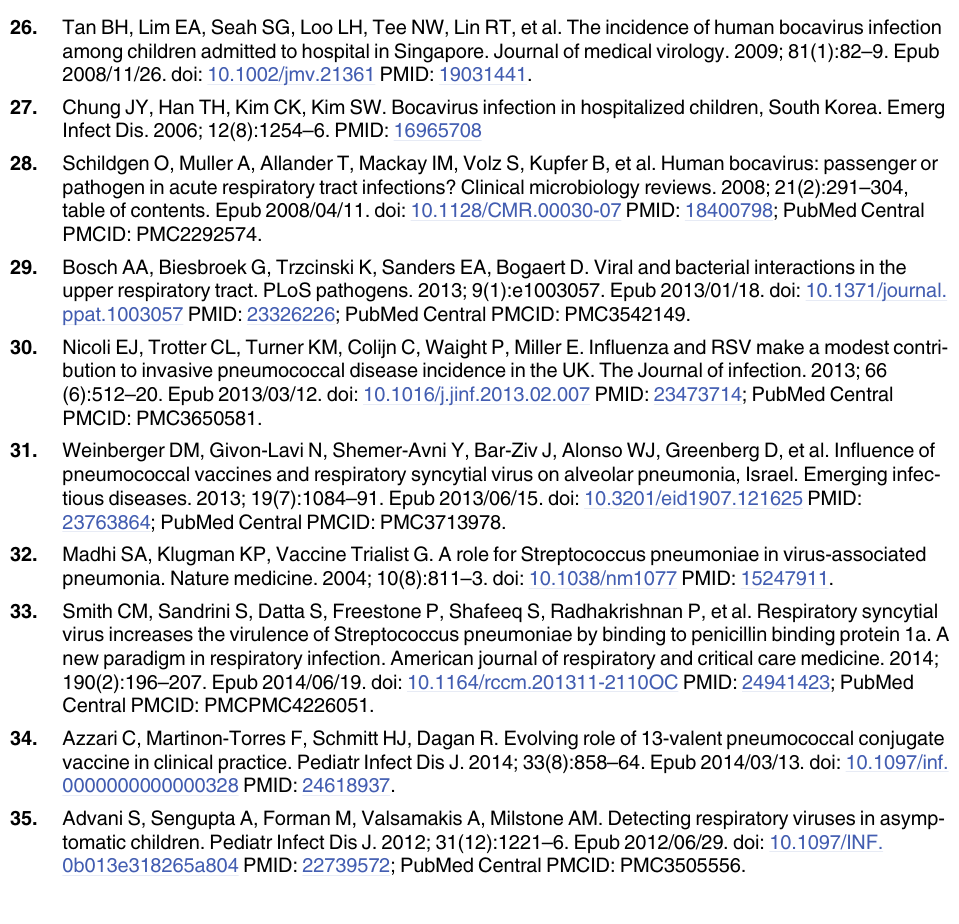
table of contents. Epub 2008/04/11. doi: 10.1128/CMR.00030-07 PMID: 18400798; PubMed Central PMCID: